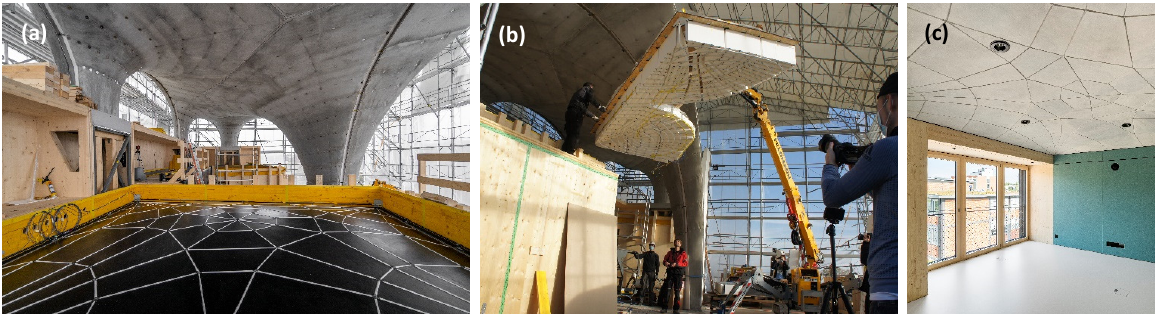
Figure 5 . HiLo funicular floor: (a) bottom temporary formwork; (b) top polyurethane stay ‐ in ‐ place formwork; (c) bottom view of final slab. Photos by Juney